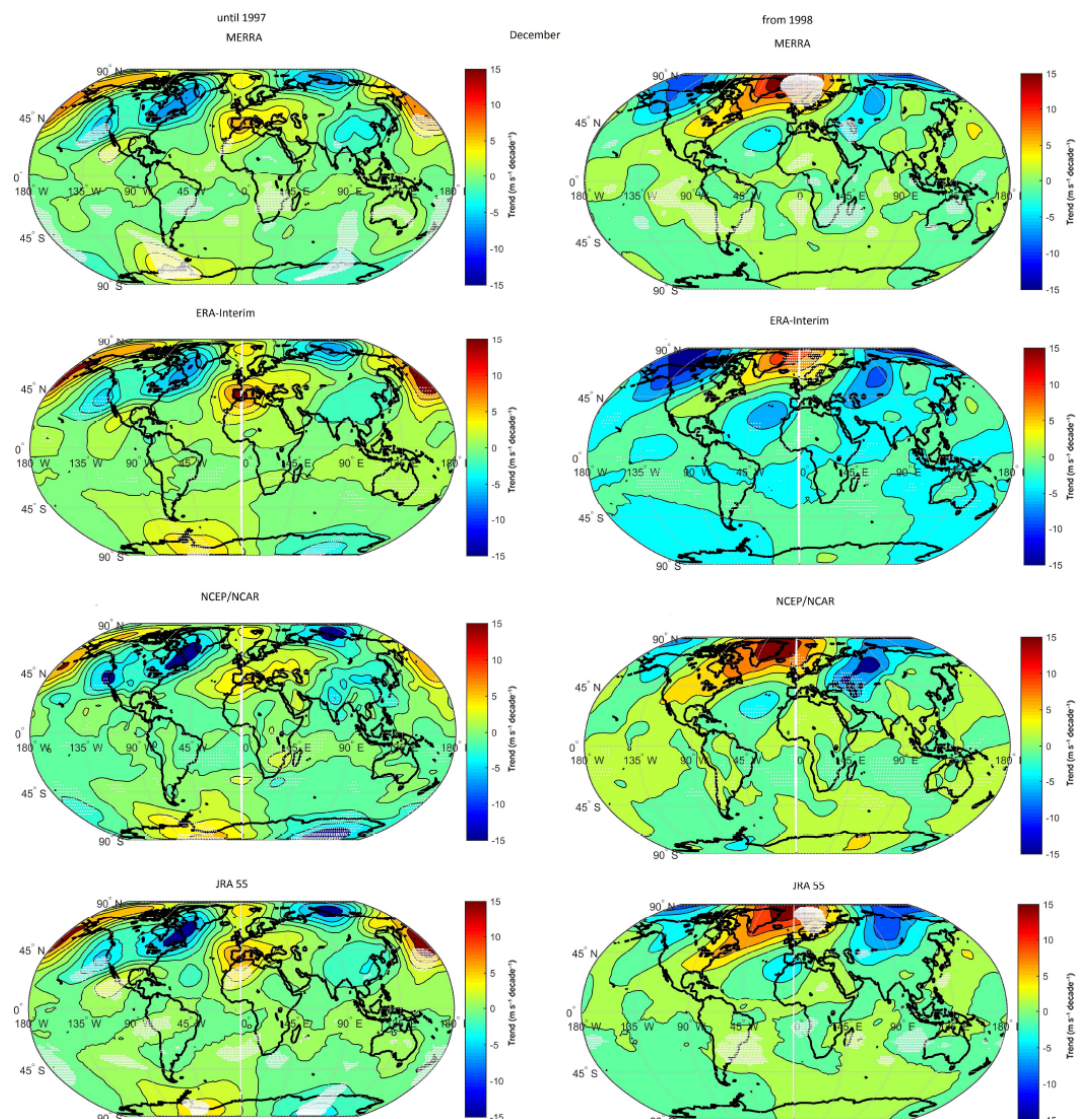
Figure 8. The same as Fig. 6 but for January. Statistical significance (95%) is highlighted by white